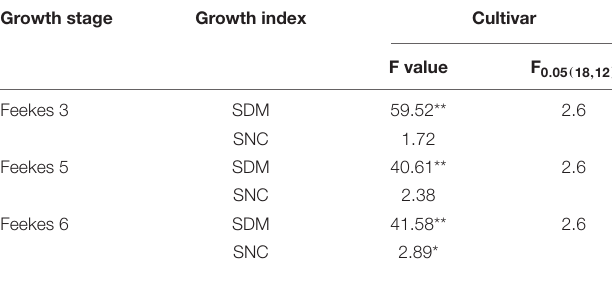
TABLE 8 | Analysis of variance of comparison of regression models between canopy cover and growth indices across different cultivars at the different growth